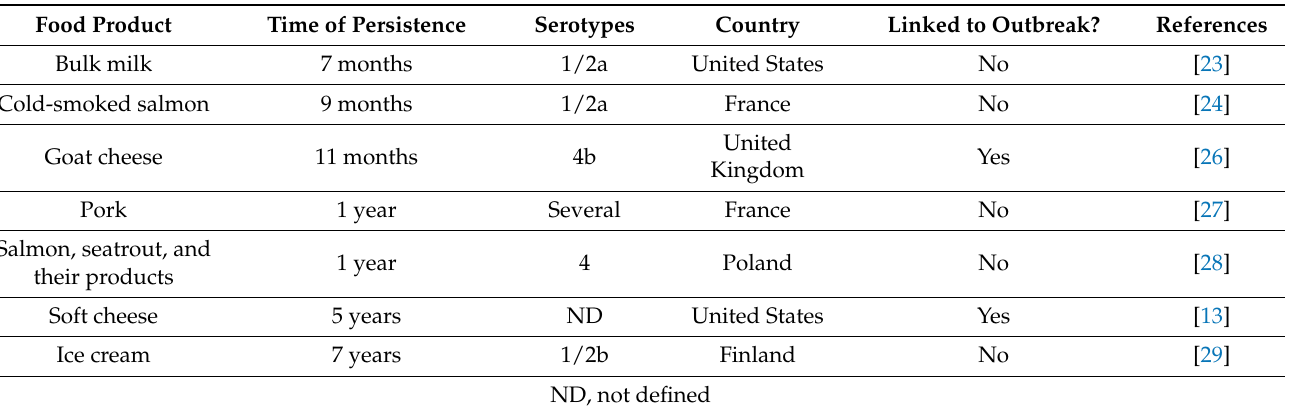
Table 1. Examples of studies demonstrating that some L. monocytogenes strains persist in food processing environments over an extended period of